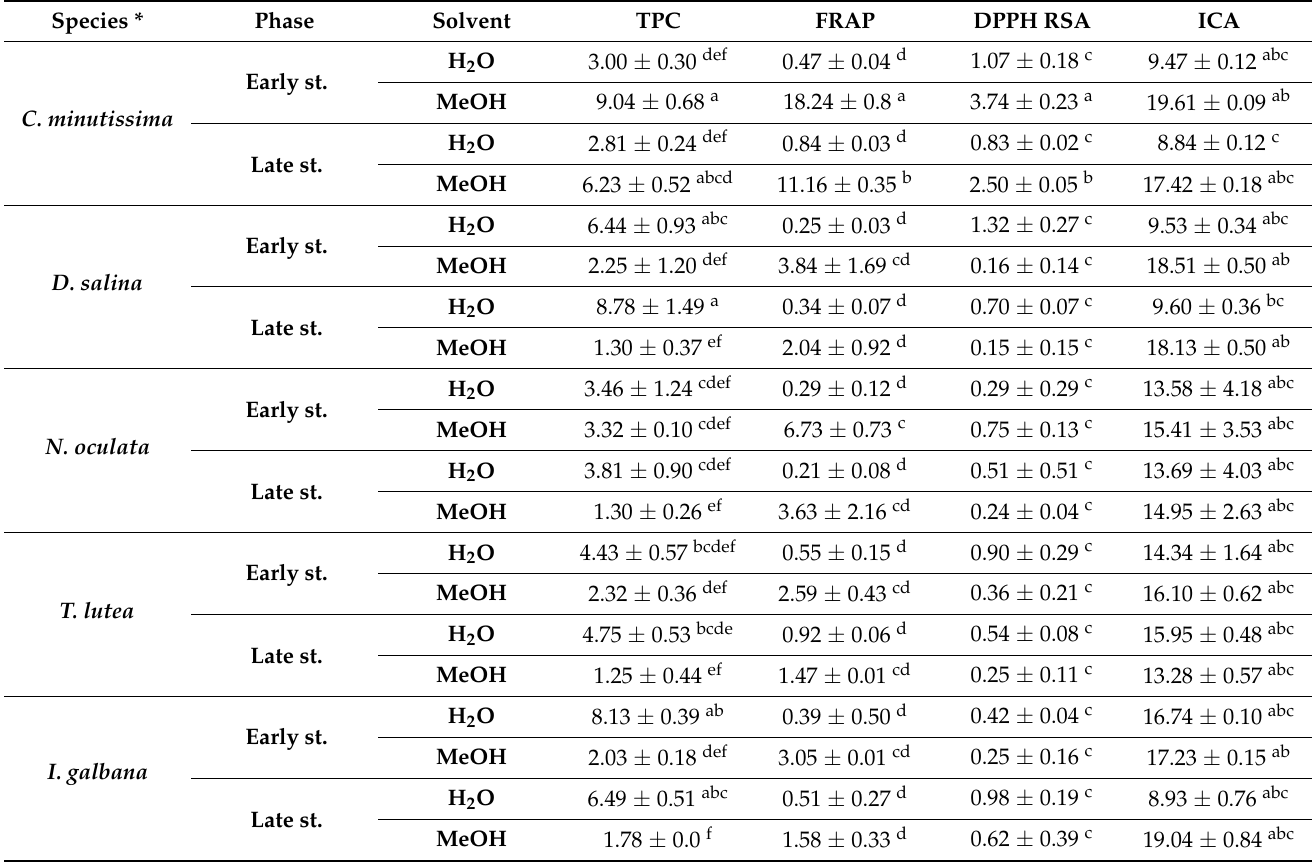
Table 4. TPC, FRAP, DPPH RSA, and ICA of aqueous and methanolic extracts during the early and late stationary phase. Values are given ± the standard